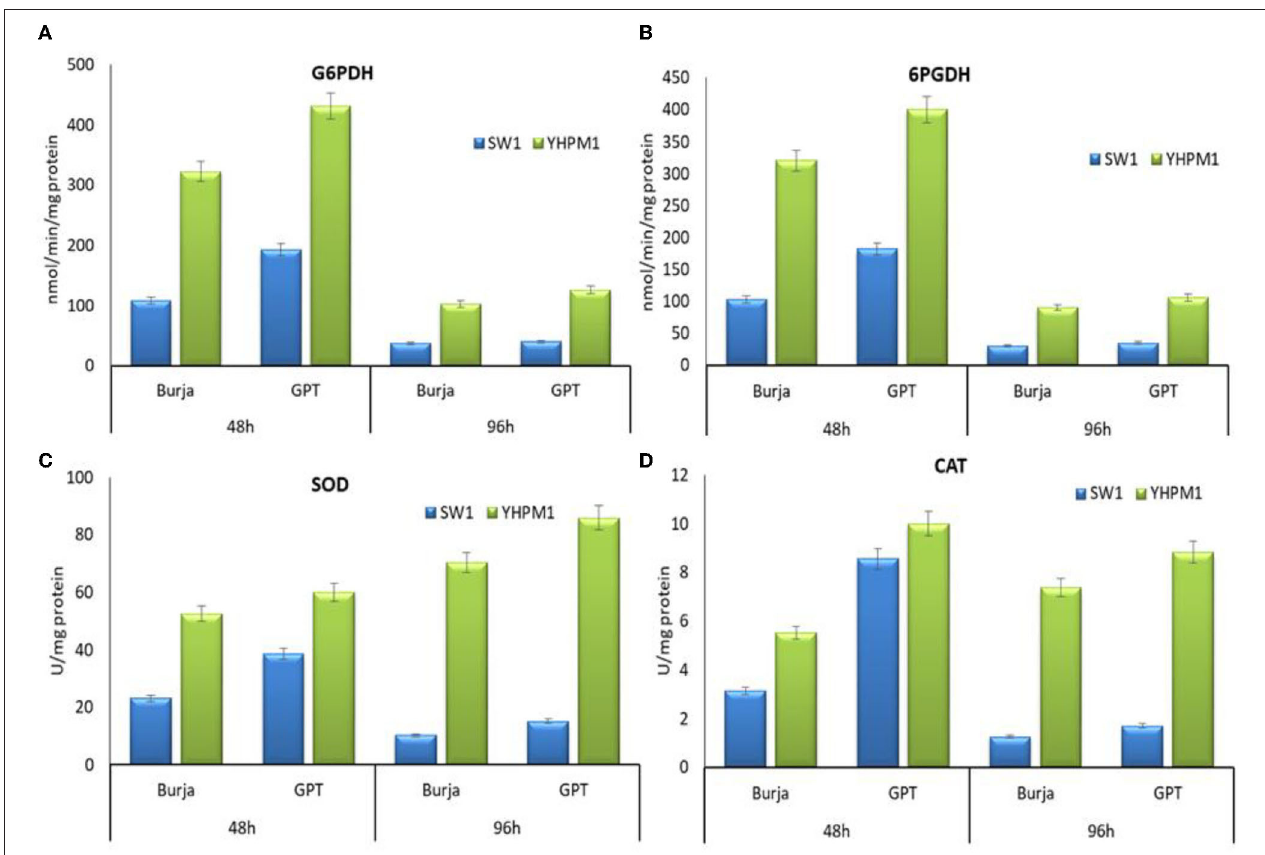
FIGURE 4 | The activity of (A) G6PDH, (B) 6PGDH, (C) SOD as well as (D) CAT of SW1 and YHPM1 cultured in 500mL shake flask for 48 and 96h of cultivation in Burja and GPT media. Values and error bars represent the means and the standard deviations of triplicate experiments ( n =